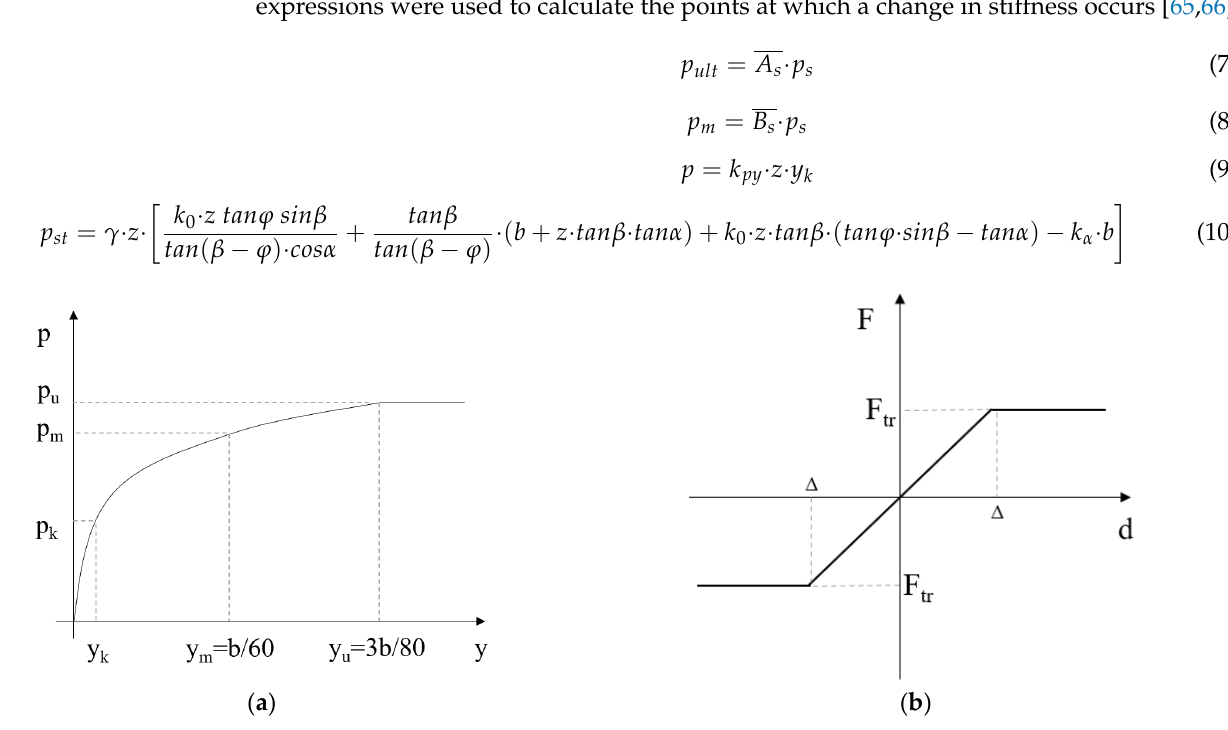
Figure 4. P-y curve created according to Reese and Van Impe [65] ( a ) and force-displacement curve used for horizontal link elements ( b ).